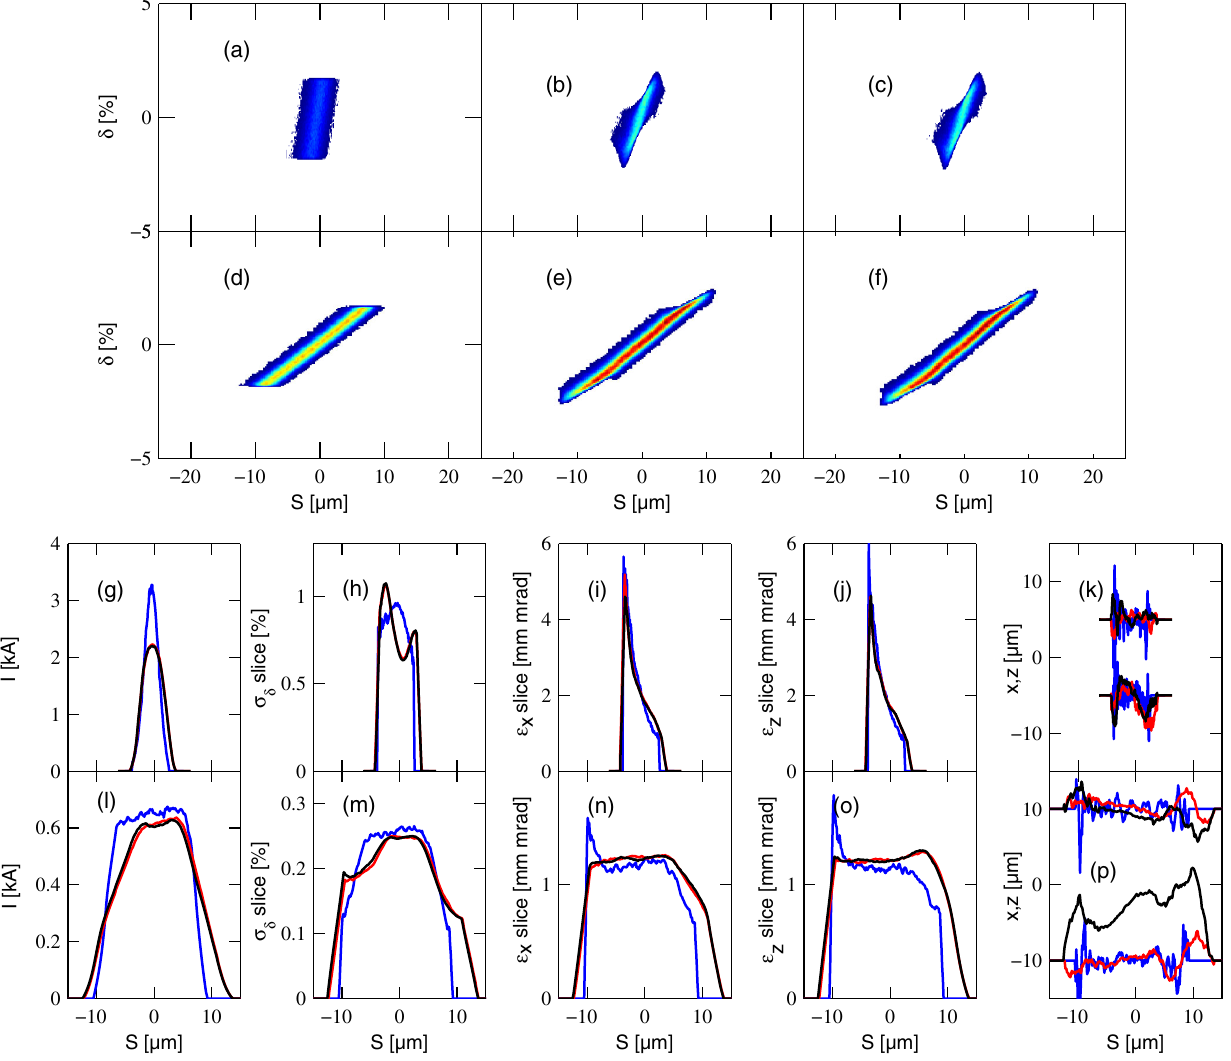
FIG. 4. Electron beam longitudinal phase-space and corresponding slice parameters at the undulator center. Simulation in the nonlinear case: without chicane for (a) and blue curves in (g – k), with chicane for (d) and blue curves in (l – p). Simulation including space-charge forces: without chicane for (b) and red curves in (g – k), with chicane for (e) and red curves in (l – p). Simulation including space-charge forces and CSR effects: without chicane for (c) and black curves of (g – k) and with chicane for (f) and black curves of (l – p). Simulation with BETA and sympletic 6D tracking using the S2I-CM optics with r 11 ¼ r 33 ¼ 10 and r 56 ¼ 0 . 4 mm for cases with